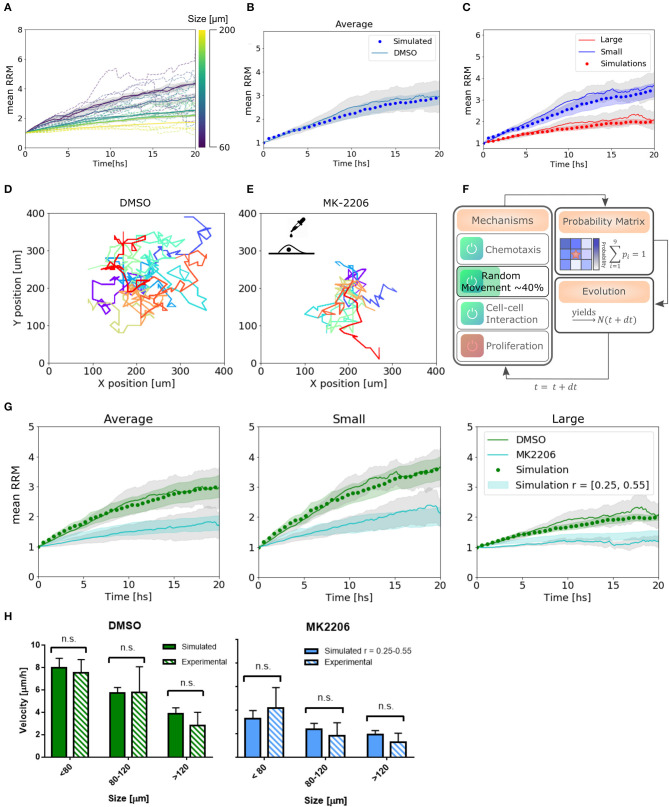
Simulations reproduce migratory behavior and predict drug-assay results. (A) Simulated curves of mean relative radial migration for different size of spheroids. (B) Average mean RRM for all sizes. Experimental and simulated curve. (C) Average mean RRM for small and large spheroids. Experimental and simulated curves. (D,E) Single cell trajectories for the diffusion coefficients measured for DMSO and MK-2206 treated cells in monolayer. (F) Modification in the model: Only random movement (diffusion) of the cells was altered in the same range indicated by experimental results. (G) Prediction of the model and experimental results with MK-2206 treatment for all spheroids (left). Prediction and experimental results for small (N = 12) and large (N = 11) spheroids separately. (H) Average invasion velocity calculated from linear fit of RRM data for each spheroid during the first 7.5 h of invasion. Non-significant differences have been observed for simulated and experimental data both for MK-2206 treatment and DMSO control. While for DMSO the simulated data corresponds to the optimum set of parameters, for MK-2206 an uniform distribution of the random parameter r between 0.25 and 0.55 was used.